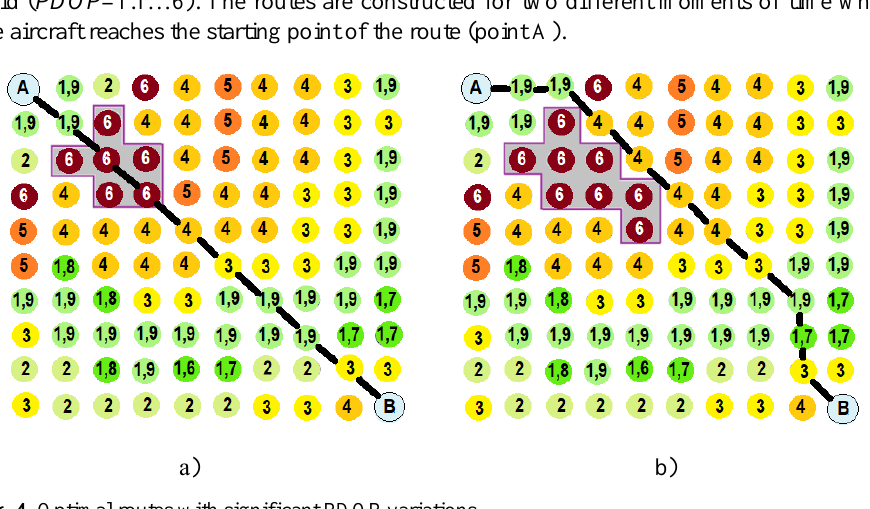
Figure 7 represents the aircraft flight tracks for two cases: a track heuristically chosen by the crew for avoiding prohibited zones (track 1) and an optimal track (track